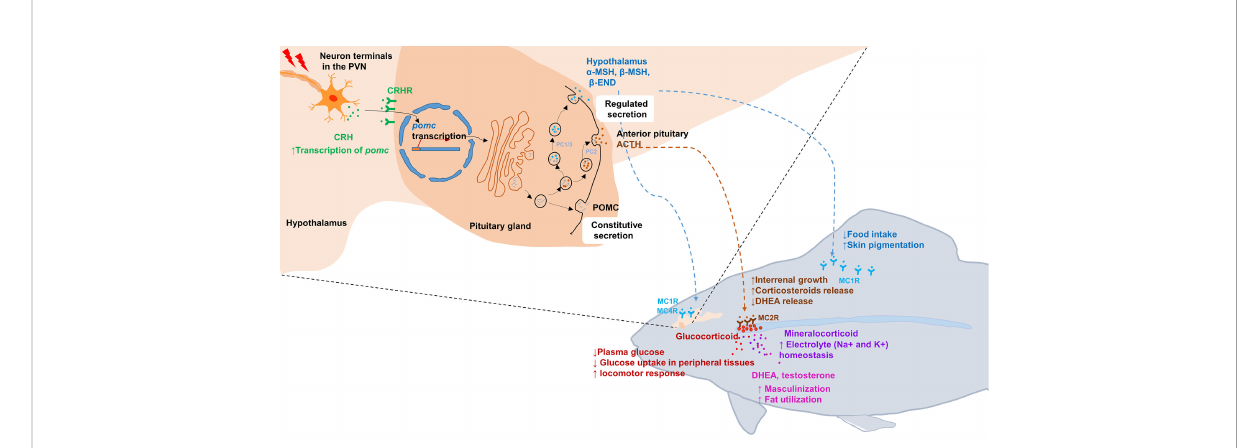
FIGURE 1 Schematic illustration of the hypothalamic – pituitary – inter-renal endocrine axis in stress and metabolisms in fi sh. Top left portion shows synthesis of POMCa in the hypothalamus and pituitary gland. In response to stress, CRH in the PVN is released into pituitary portal vessels that reach the anterior pituitary gland. Binding of CRH to its receptor CRHR on pituitary corticotropes induces the transcription of pomc . After translated into pro-hormones, the POMC polypeptides is cleaved into mature hormone by PC1/3 and PC2, including a -MSH, b -MSH, ACTH and b -END etc. Lower right portion indicates that the POMC-derived peptides bind with its corresponding receptors and activated downstream signaling. MSHs bind with MC1R to suppress appetite by increasing satiety in hypothalamus and promoting melanosomes dispersion in skin. Moreover, MSHs bind with MC4R to regulate energy homeostasis in hypothalamus. In fi sh interrenal gland, ACTH can speci fi cally bind with MC2R to promote interrenal growth and syntheses and releasing of steroid hormones, including glucocorticoids, mineralocorticoid, DHEA and testosterone. Once these steroid hormones act on target tissues and organs, a series of physiological and metabolic activities are initiated, such as glucose uptake, electrolyte homeostasis, sexual differentiation and lipid utilization etc. ACTH, adrenocorticotrophic hormone; b -END, b -